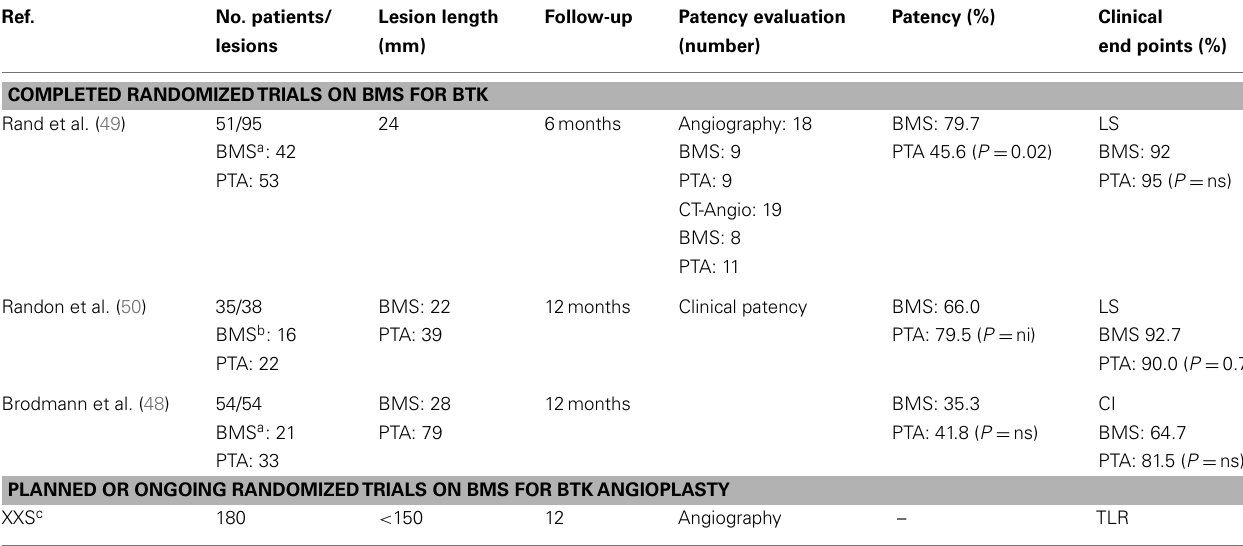
Table 2 | Overview of randomized series comparing BMS with POBA for tibial revascularization in CLI patients .